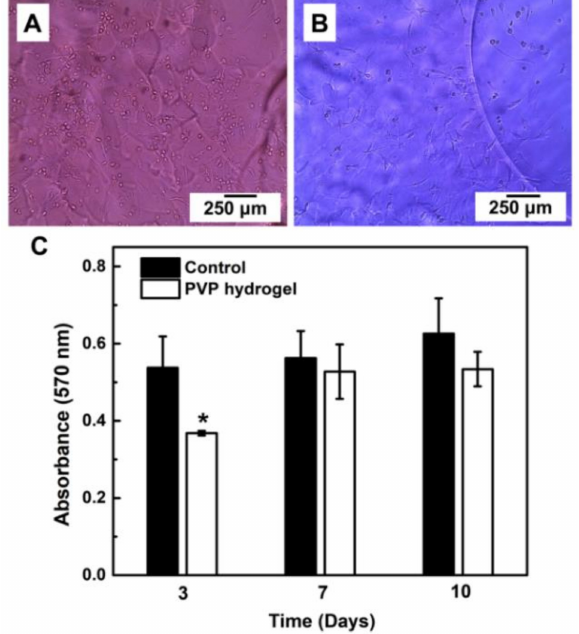
Figure 9. Hydrogel’s cytotoxicity against human oral mucosa stem cells (hOMSCs). ( A , B ) Optical microscope images of the cells in direct contact with PVP hydrogel at day 3 and 7, respectively. ( C ) Cell metabolic activity, results expressed as mean ± SD, (*) represents significant difference ( p < 0.05) between groups and throughout days (n = 3; two-way ANOVA,